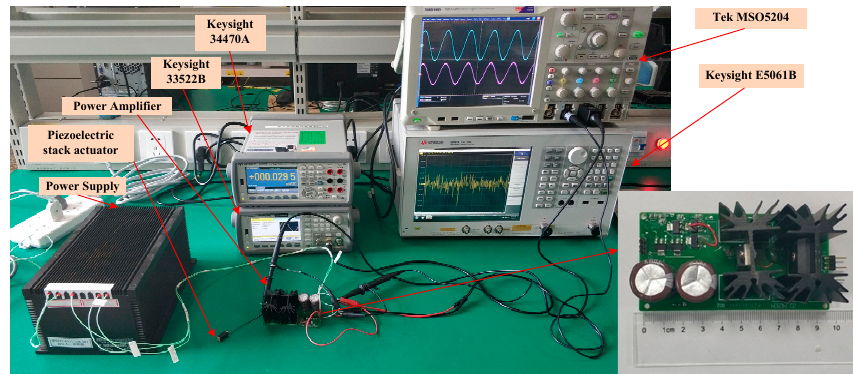
Figure 18. Photograph of the power amplifier’s test.